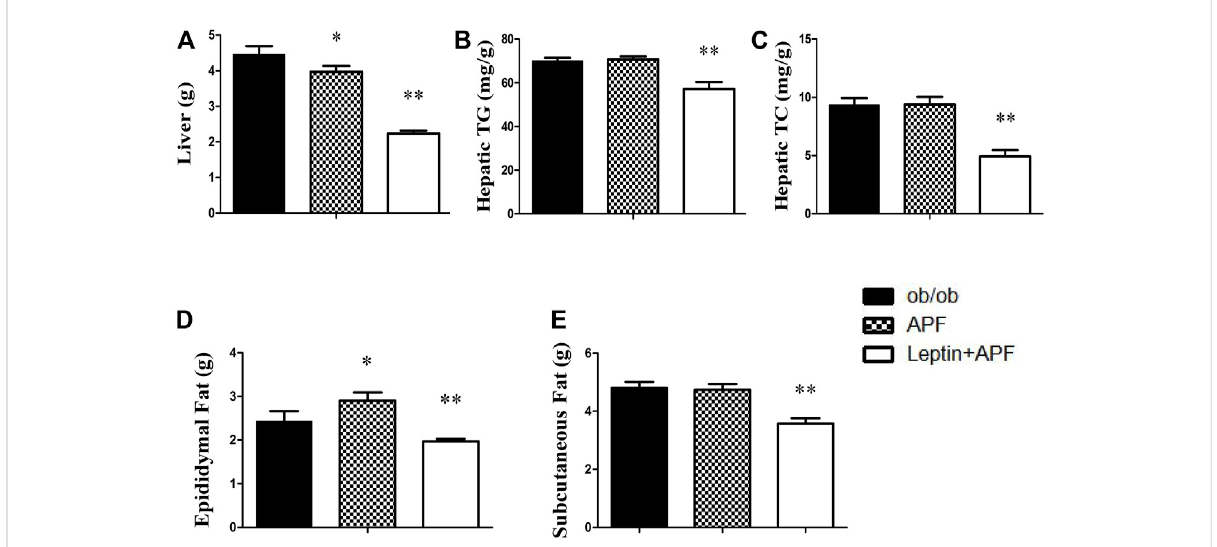
FIGURE 6 Effects of APF and supplementary Leptin on abdominal obesity in ob/ob mice. Liver weight (A) , hepatic TG (B) , hepatic TC (C) , epidydymal fat mass (D) andsubcutaneousfatmass (E) ofob/obgroup(blackbars),APFgroup(gridbars)andAPF+leptingroup(whitebars)aftertreatmentwithAPF 16 weeks or APF + lepin 3 weeks. Values are means ± SEMs, n = 7 – 8 per group. * p < 0.05, ** p < 0.01 versus ob/ob group.